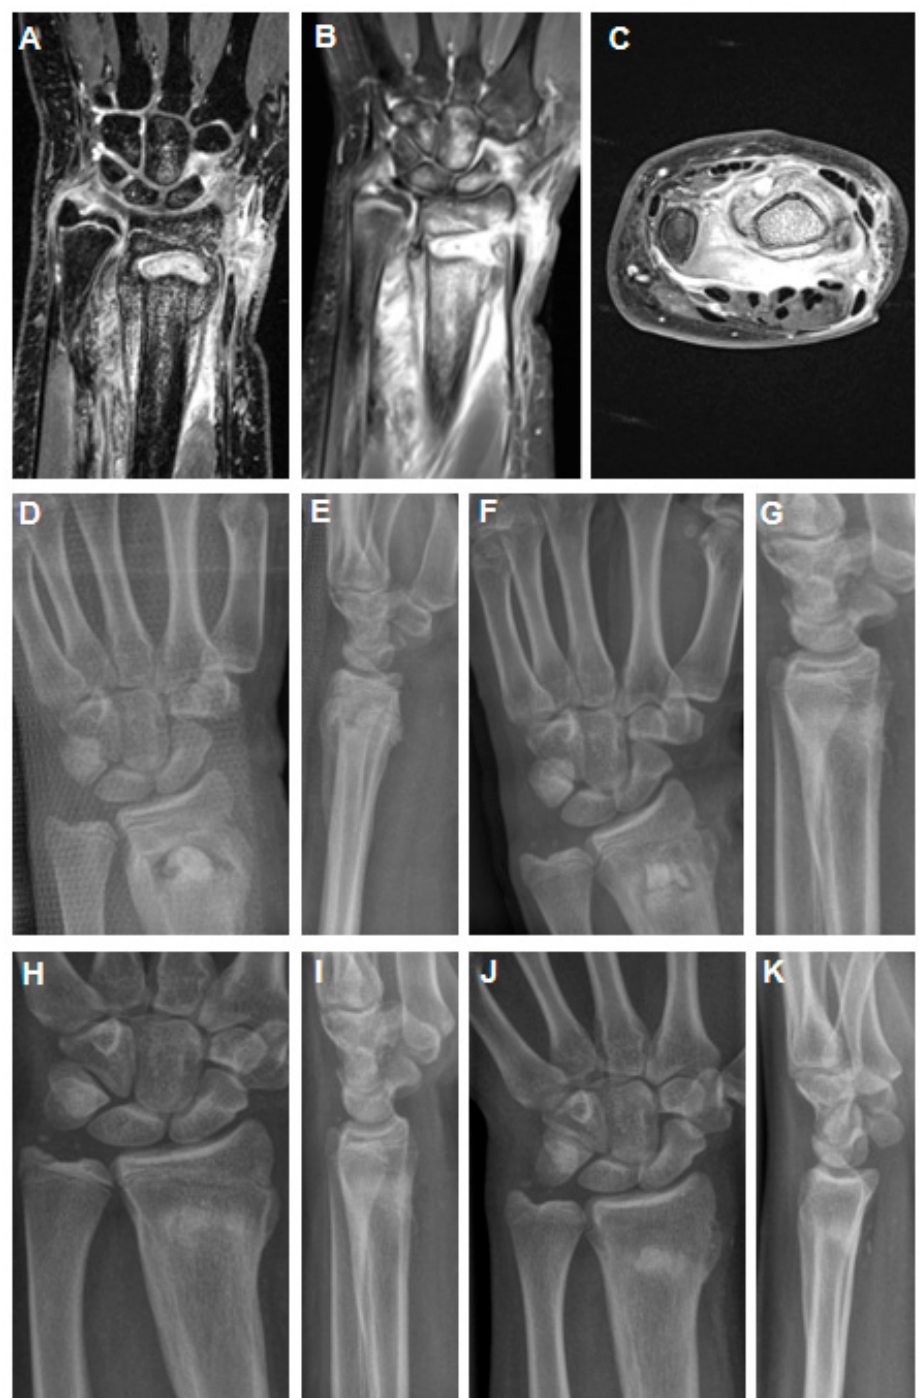
Figure 2. MRI imaging 4 weeks after K-wire removal after initial closed reduction and K-wire fixation of a dislocated distal radius fracture in an 11-year-old girl ( A – C ). Abscess formation in the distal metaphysis of the radius with intensive periosteal reaction ( A , B ) and affection of the growth through the K-wire channel. Axial section revealed strong abscess into the palmar soft tissues ( C ). Post-operative X-rays show filling of the metaphyseal defect area with a PMMA spacer ( D , E ). The spacer was exchanged against a hydroxyapatite–calcium sulphate biomaterial 9 weeks after stage 1 ( F , G ). After 6 weeks, there was already good remodeling of the metaphyseal bone zone ( H , I ). At midterm follow-up of 16 months, there was correct alignment of the wrist joint with premature closure of the growth plate ( J , K ).